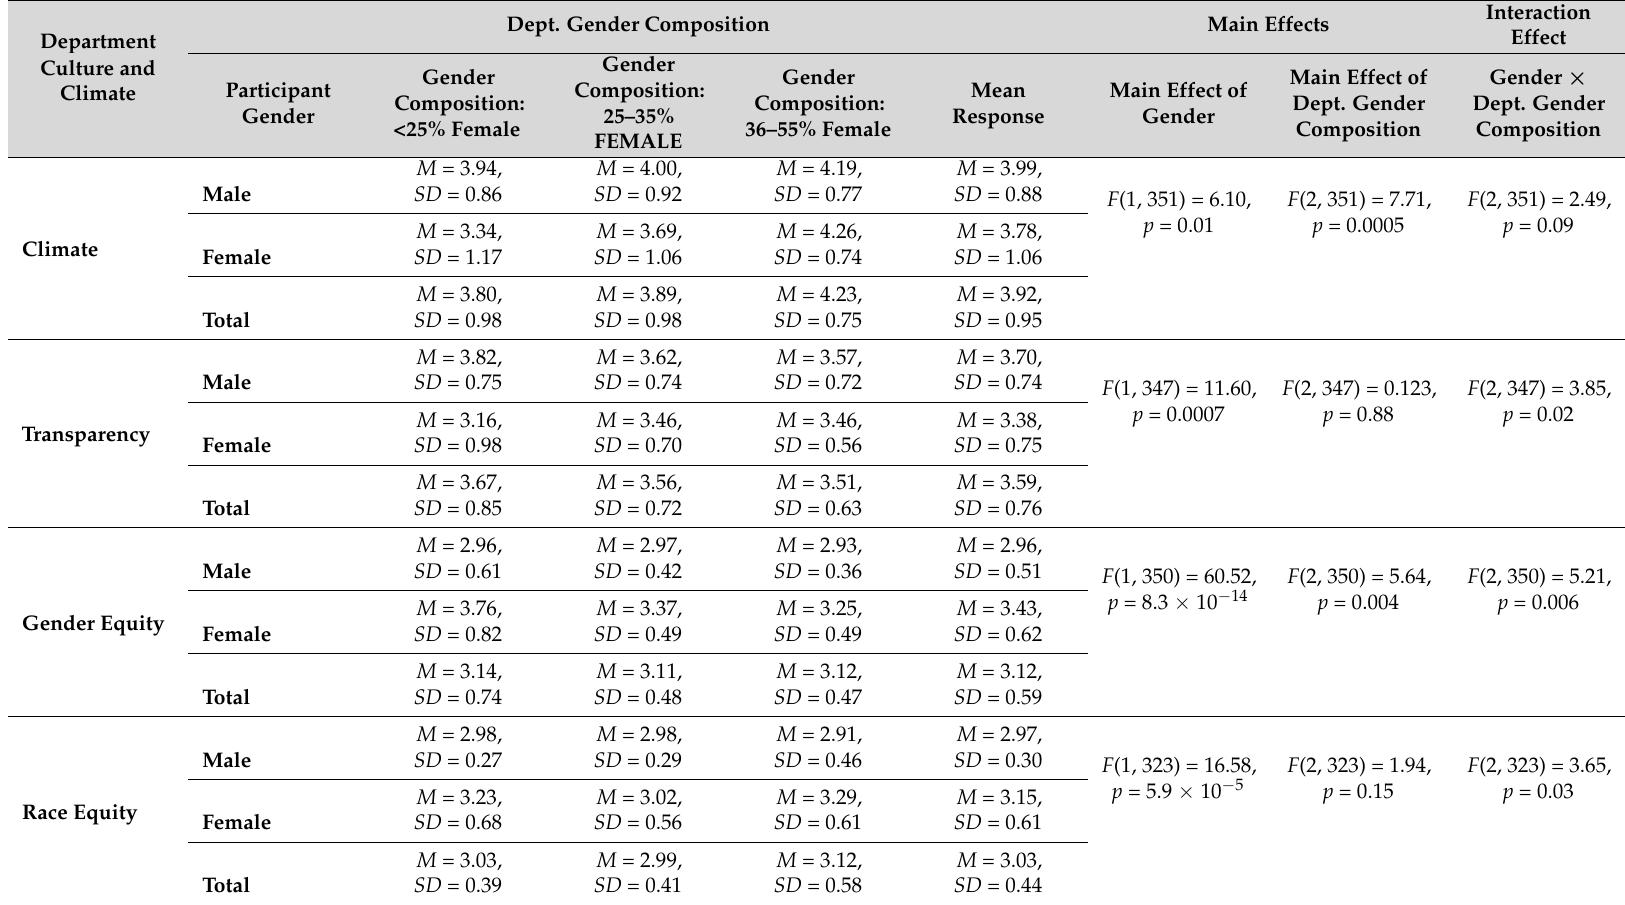
Table 2. Influence of gender and department gender composition on department